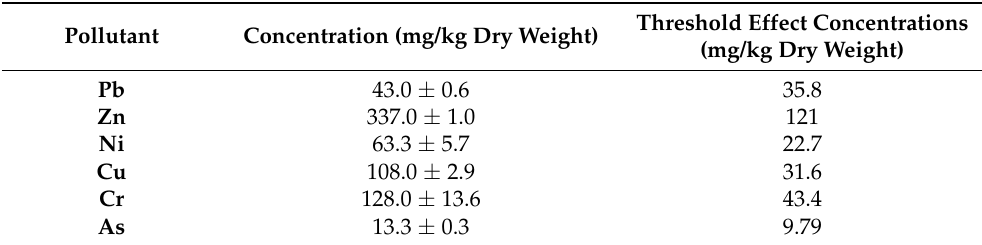
Table 1. Pollutant concentrations of SWP sediments and, for comparison, reported threshold effect concentrations for amphibians